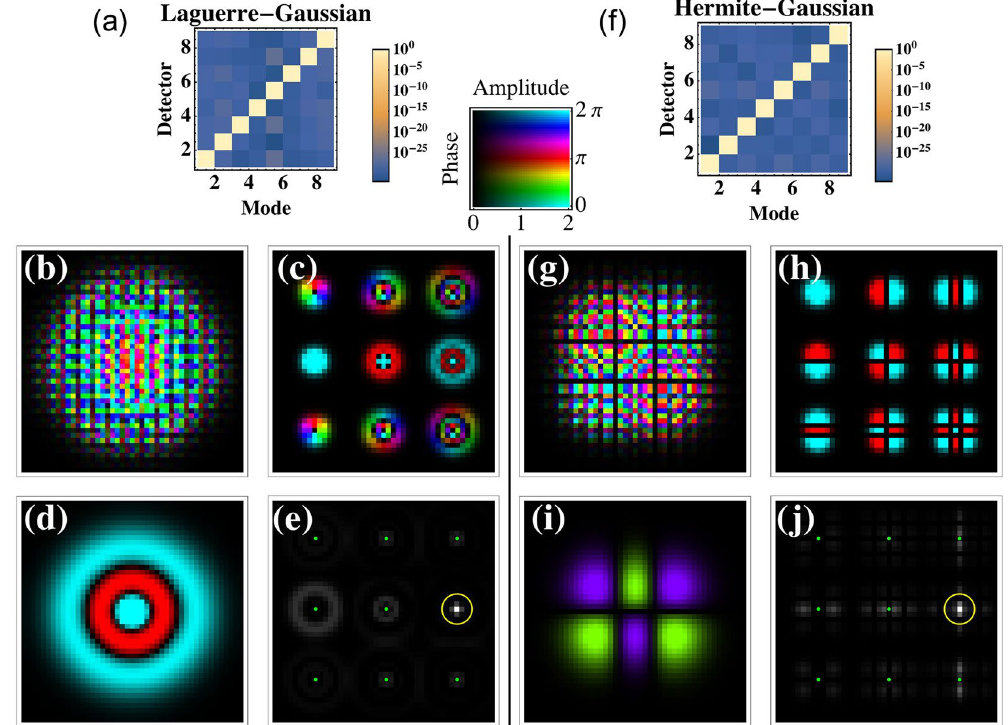
Figure 1. Decomposition of 9 Laguerre-Gaussian ( a – e ) and 9 Hermite-Gaussian ( f – j ) beams onto array of 9 single point detectors. ( a , f ) Detected intensity, in log scale, when array of detectors is illuminated by the corresponding modes. The intensity of each of the 9 detectors is displayed for each mode illumination. ( b , g ) Phase (hue) and amplitude (luminosity) of the mode splitting decomposition mask. Center inset shows the phase and amplitude color scheme used. ( c , h ) Fourier transform of the mode splitting decomposition mask. ( d , i ) Example incident mode and ( e , j ) corresponding output field. The center of the yellow circle is the position of the correct detector and the green dots represent the position of the other 8 detectors (Code available online) 27 .